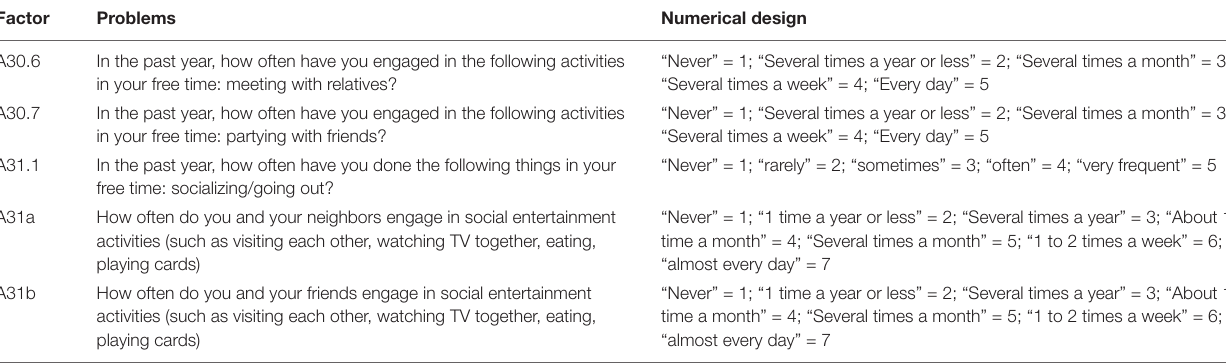
TABLE 1 | Basic indicators of villagers’ social relationship